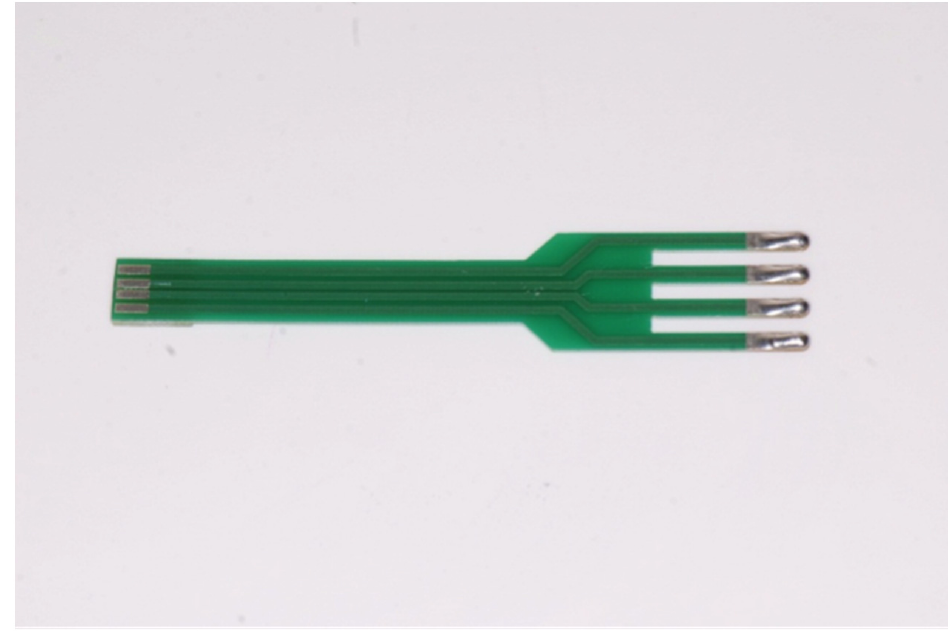
Figure 2. “the fork”. Figure 2. “The